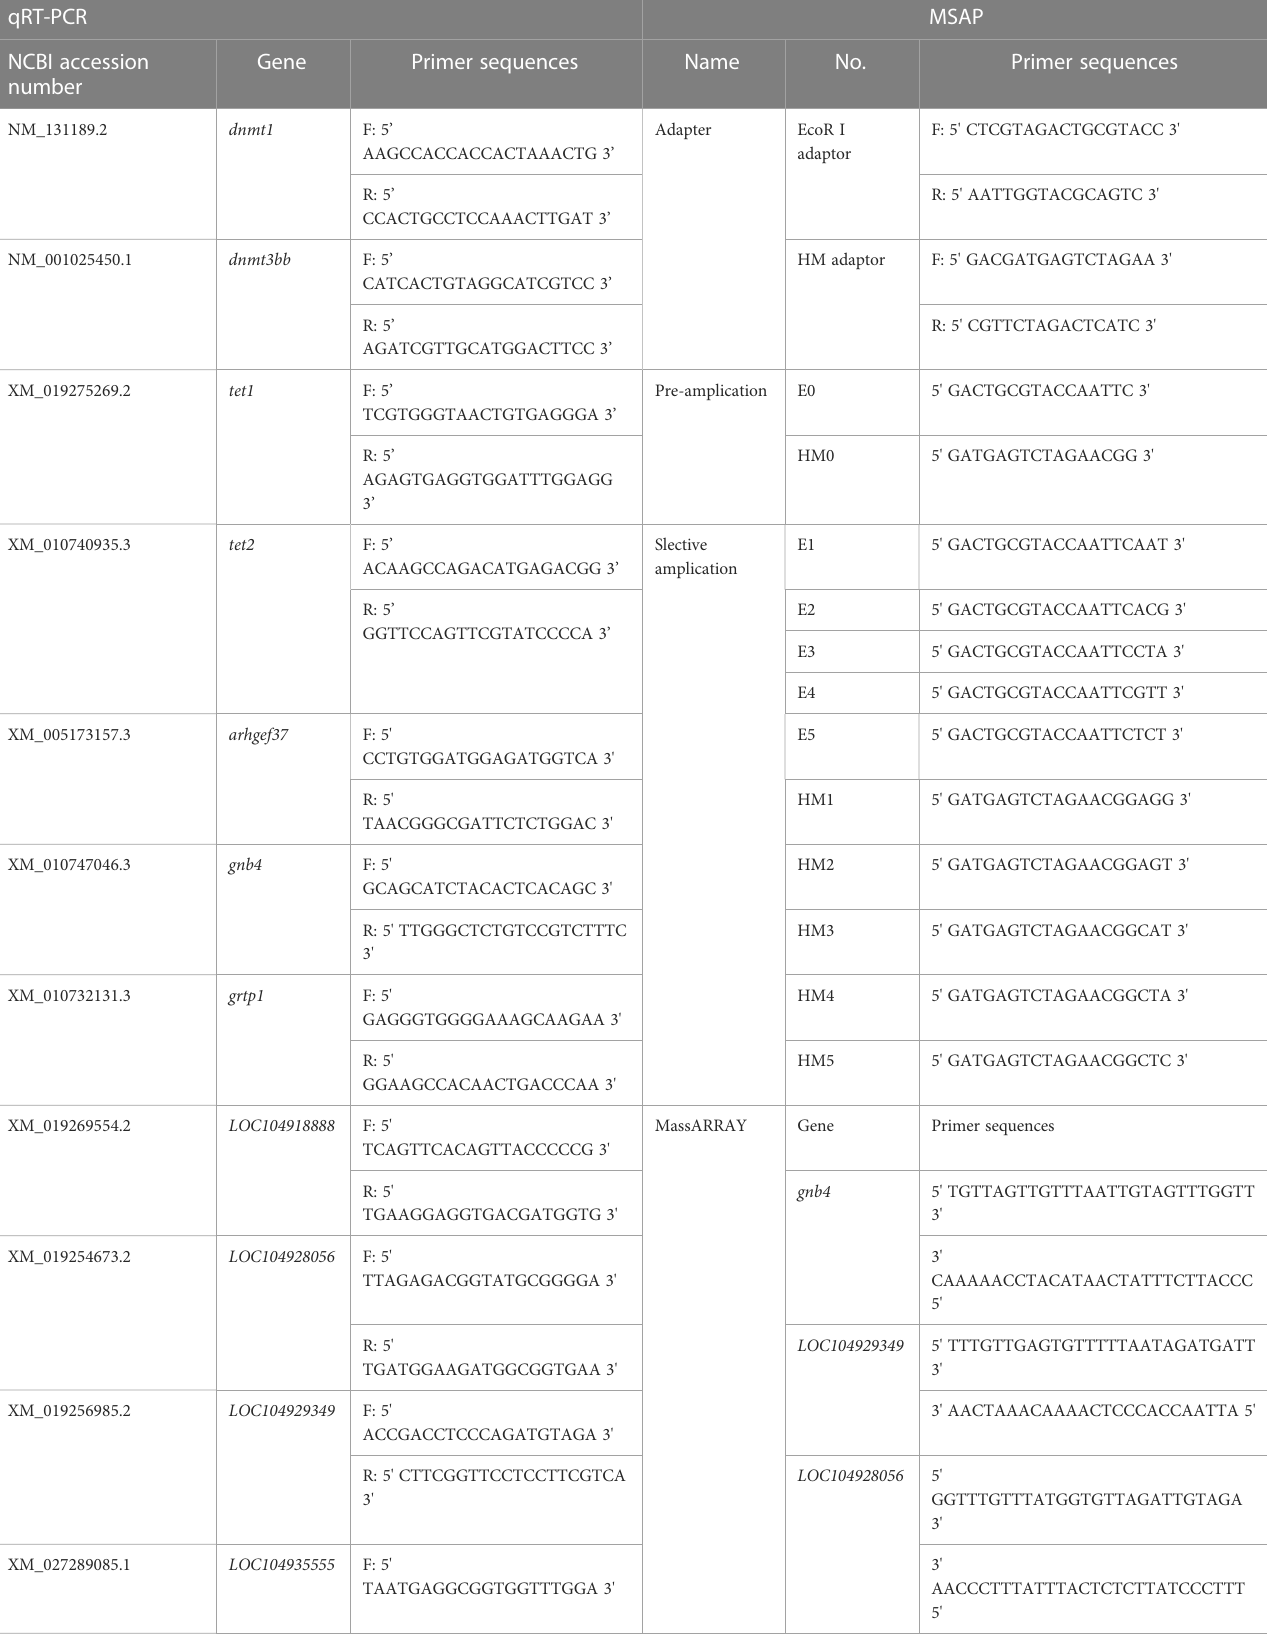
TABLE 1 Primers used in this